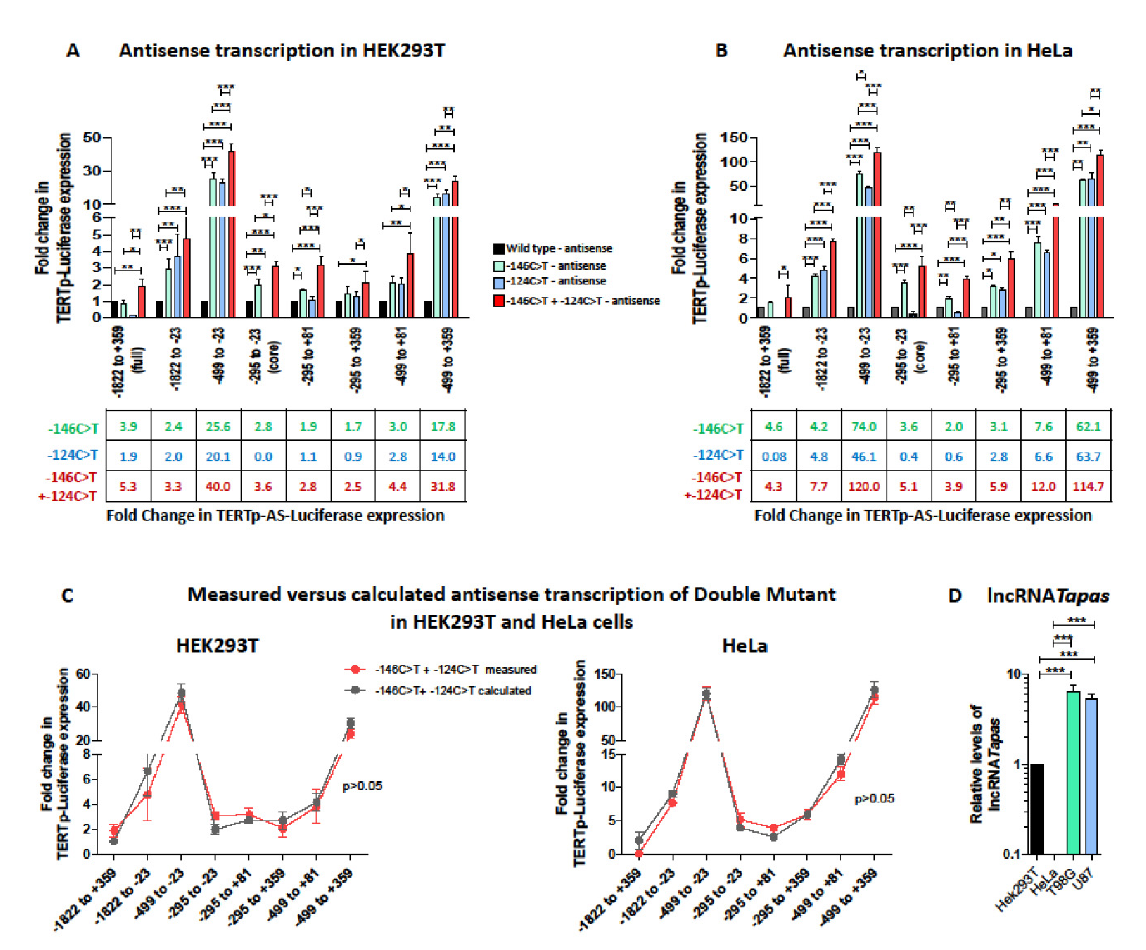
Figure 3. Impact of TERT promoter mutations − 146C>T and − 124C>T on antisense expression from the TERT promoter. ( A , B ). Fold-change in TERT expression in HEK293T ( A ) and HeLa ( B ) cells transfected with the wt or mutant TERTp-luciferase reporter constructs. HEK293T (1.2 × 10 5 cells/well) or HeLa (5 × 10 4 cells/well) were seeded in a 48-well plate and transfected with 200 ng of each of the wt (black) or mutated (green: − 146C>T; blue: − 124C>T; red: − 146C>T + − 124C>T) TERTp-AS-luciferase vectors + HSV-TK-Renilla-luciferase for normalization (10 ng in HEK293T and 20 ng in HeLa) for 48 h. Firefly Luciferase RLU was normalized to Renilla Luciferase RLU and transcription levels were further normalized to the wt for each TERT promoter construct. Results are the mean of at least 3 independent experiments carried out in duplicate. Error bars represent standard error. ( C ). Comparison of the measured and estimated fold increase in TERT antisense expression for the double mutant. The fold increase in TERTp-AS-luciferase expression measured for the double mutant (pink) was compared with the calculated sum of the fold increase due to the − 146C>T mutation + − 124C>T mutation (grey). ( D ). Relative expression of lncRNA TAPAS in different cell lines. Total RNA was extracted from cells (2 × 10 5 cells) cultured for 48 h and 1 µg RNA was reverse transcribed. Relative levels of lncRNA TAPAS were compared in HEK293T, HeLa, T98G ( − 146C>T) and U87 ( − 124C>T) cells using the 2 − ΔΔ Ct method and relative expression levels were calculated by comparison with HEK293T cells. Experiments were performed in duplicate wells and the mean +/ − standard error of two independent experiments are represented. Differences were compared using a one-way ANOVA followed by a Newman–Keuls post-hoc test for pairwise comparison. * indicates p < 0.05, ** indicates p < 0.01, *** indicates p < 0.001.